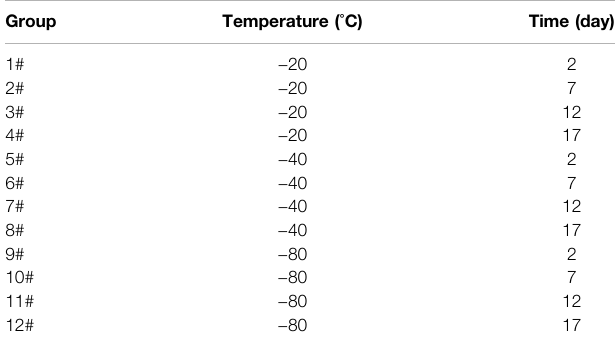
TABLE 1 | The 12 groups of samples with different freezing temperatures and time.